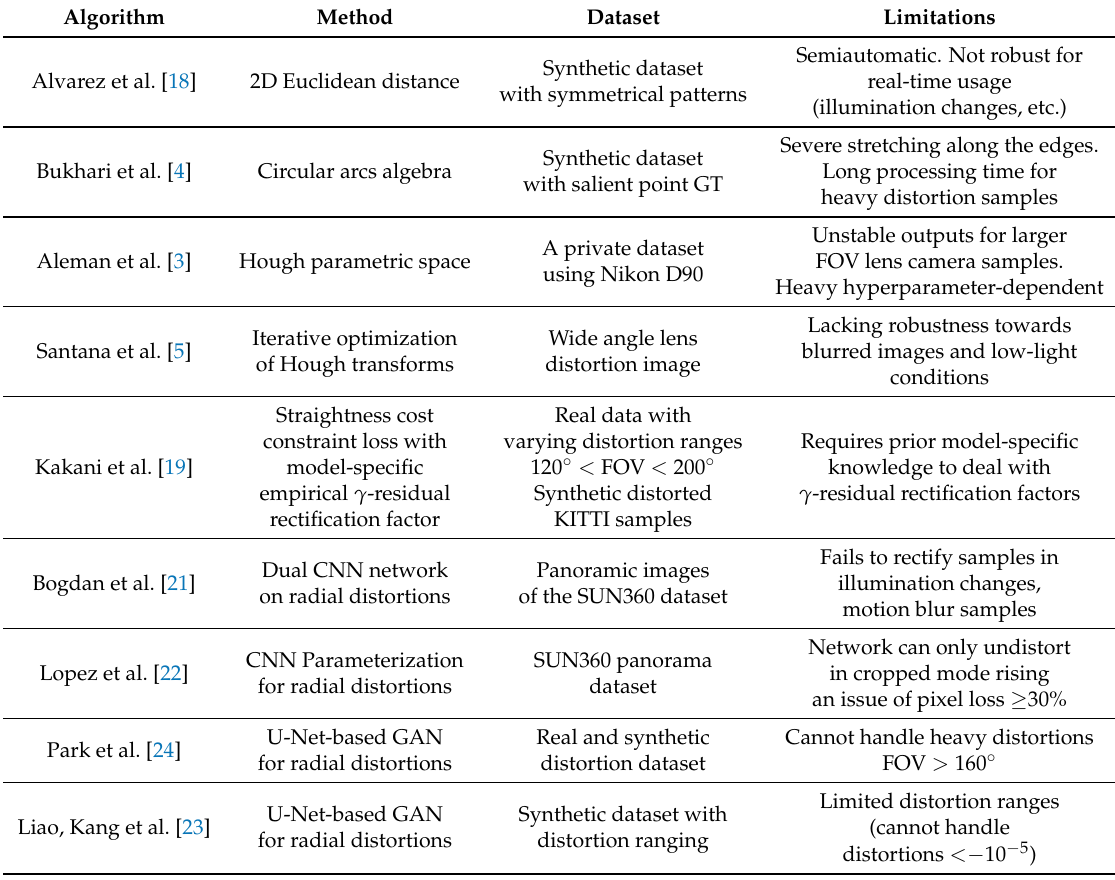
Table 1. Insights of traditional and learning-based automatic distortion rectification